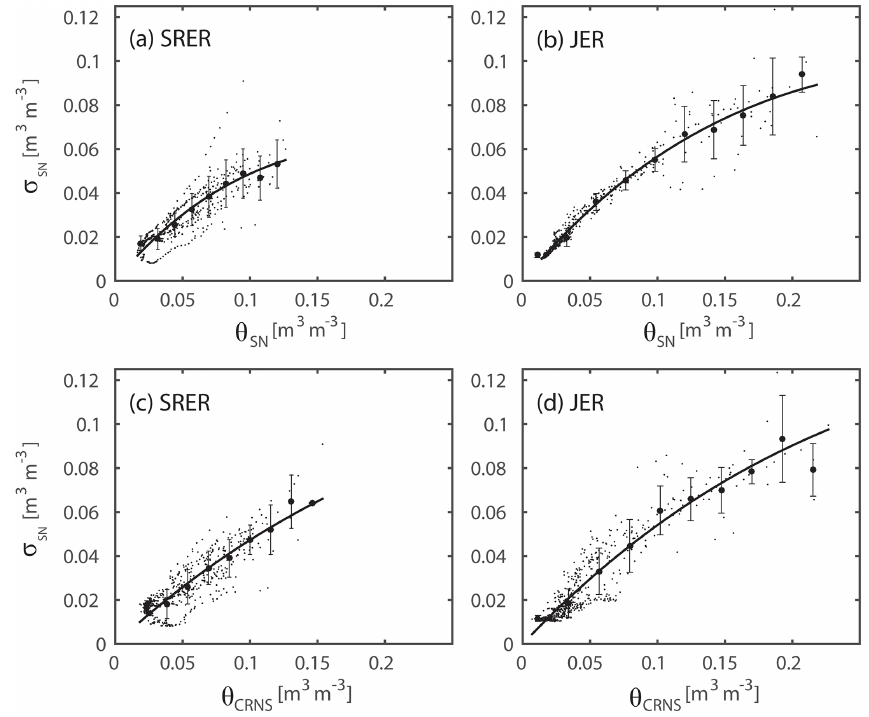
Figure 6. Soil moisture spatial variability as a function of the spatially averaged distributed sensor network ( θ SN , top) and the CRNS method ( θ CRNS , bottom) for (a, c) SRER and (b, d) JER. Bin averages and ± 1 standard deviation are shown (circles and error bars) for bin widths of 0.015m 3 m − 3 at SRER and 0.025 m 3 m − 3 at JER. Regressions for the relations of σ with < θ > are valid for the entire data